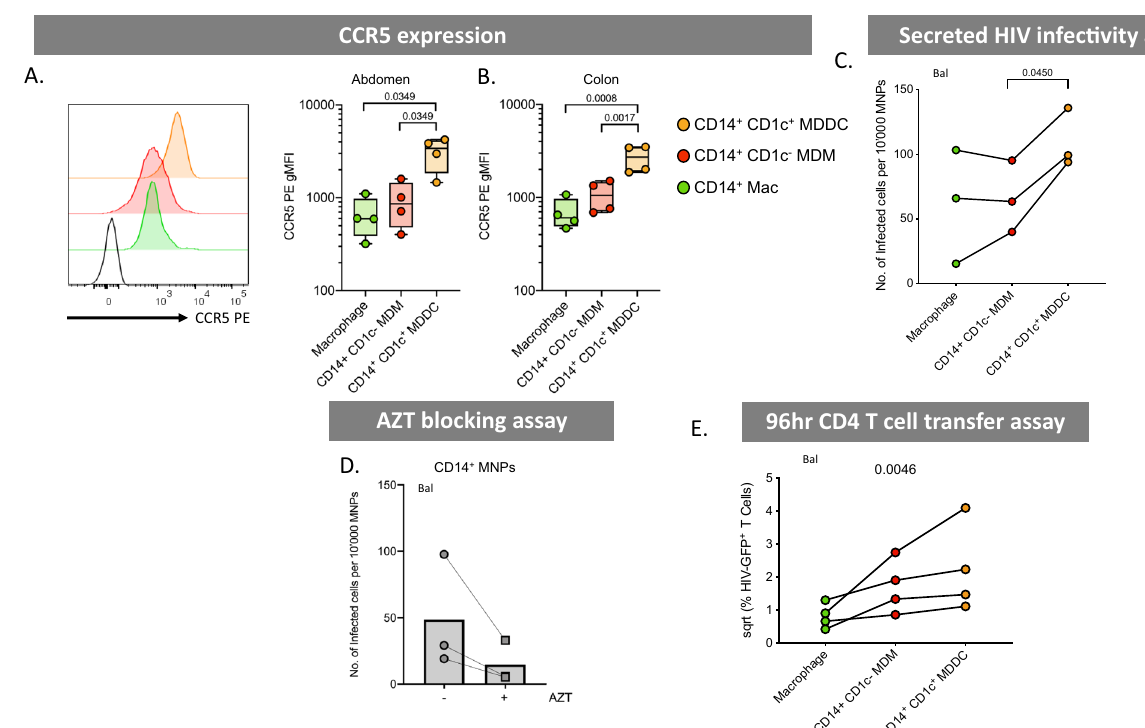
Fig. 7 HIV infectability and transfer capacity of CD14-expressing dermal mononuclear phagocytes. A CCR5 expression was determined on CD14- expressing MNPs liberated from collagenase type IV digested tissue. Left: histogram representing one abdominal skin donor with black, un fi lled histogram representing FMO control. Right: geometric mean fl uorescent intensity (gMFI) minus FMO control plotted from abdominal skin ( n = 4), plotted as box and whisker plots, box representing the upper and lower quartile, central line representing the median, the whiskers the minimum and maximum of each cell subset and each donor represented by an individual dot. Statistics were generated using a RM one-way ANOVA with Holm – Sidak ’ s multiple comparisons with adjusted P values shown. B CCR5 expression was investigated in colon ( n = 4) plotted as box and whisker plots, box representing the upper and lower quartile, central line representing the median, the whiskers the minimum and maximum of each cell subset and each donor represented by an individual dot. Statistics were generated as in A . C CD14-expressing MNP subsets were FACS isolated and incubated with HIV bal for 2 h before being thoroughly washed off. Cells were then cultured for an additional 96 h in human skin fi broblast conditioned media. Cell supernatants were taken and assessed for secreted HIV using a TZMBL infection assay, with the number of infected cells per 10,000 MNPs calculated and graphed. Individual dots represent three donors matched by connecting lines. Statistics were generated as in A . D Combined CD14-expressing MNPs were sorted and pre-treated for 1 h with 50 µ M azidothymidine (AZT) before 2 h culture with HIV Bal . Cells were washed three times and incubated for a further 48 h with AZT and then washed three more times. Cells were cultured for another 48 h before cell supernatants were collected and secreted HIV was assessed using a TZMBL infection assay. Each donor represented by individual point matched with joining lines, circles represent untreated cells and squares represent AZT treated cells, column representing the mean. E JLTRs were added to cell cultures from C after supernatants removed, at a ratio of 4:1 and cultured for a further 96 h. Transfer of HIV to T cells was determined using fl ow cytometry to assess the percent of GFP + JLTRs. Raw data was square root normalised and plotted, with each dot representing four individual donors with connecting lines matching donors. Statistics were generated using a Friedman test. Macrophages (green), CD14 + CD1c − MDM (red) and CD14 + CD1c +